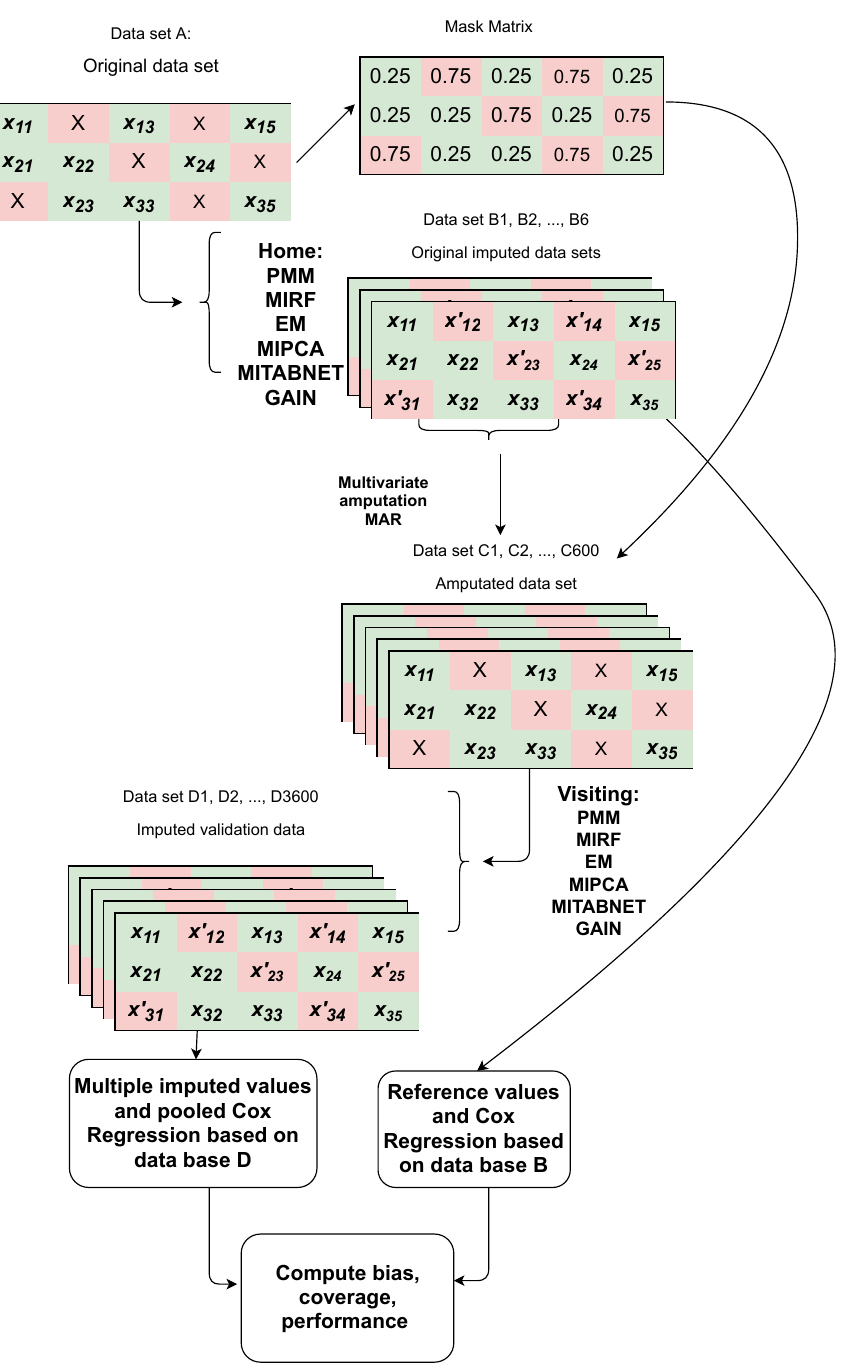
Figure 3. Generation of datasets with artificial missingness from a population of patients with NSCLC in the Flatiron database. datasets B1, B2, ..., B6 are imputed datasets with the imputation algorithms (PMM, MIRF, EM, MIPCA, MITABNET, GAIN) serving as host to the comparison or imputing at home. datasets C1, C2, ..., C600 are amputated dataset 100 for each B dataset. datasets D1, D2, ..., D3600 are imputed datasets 6 for each C dataset, the imputation algorithms are